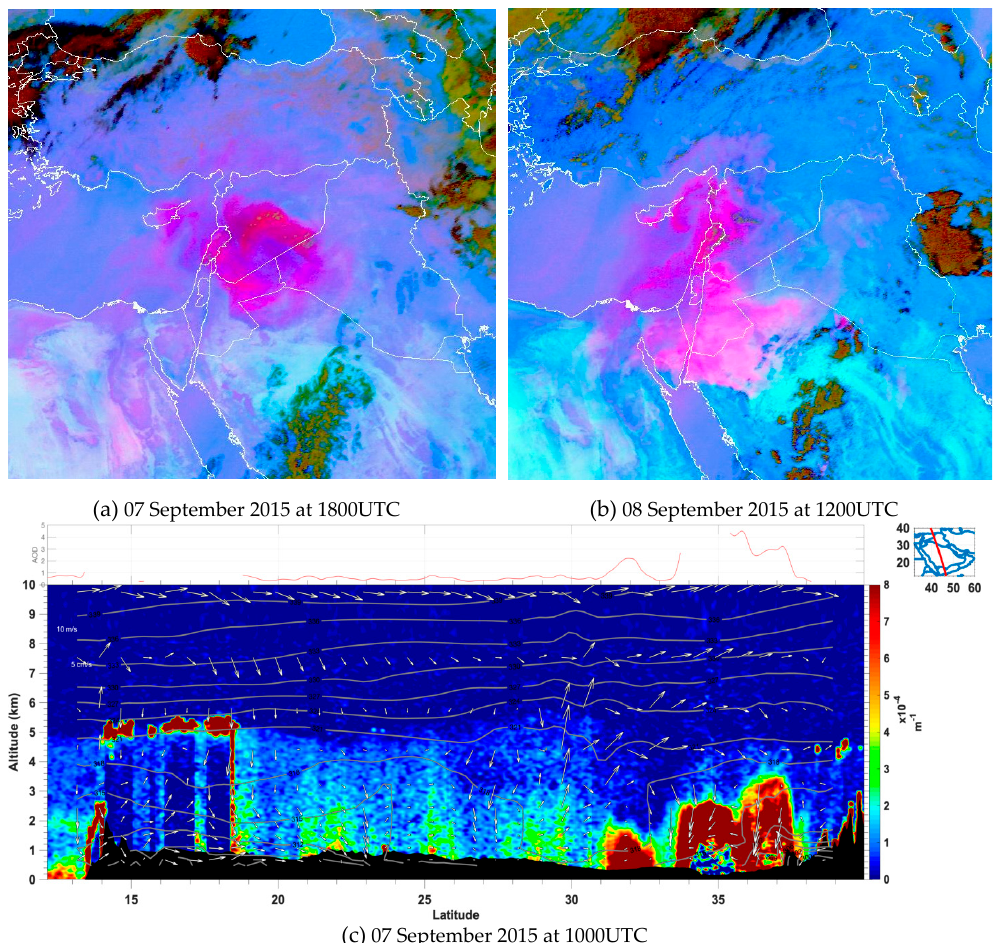
Figure 8. SEVIRI-derived false color images showing dust (pink/purple), clouds (brown/red) and differences in surface emissivity retrieved in absence of dust or clouds (light blue/blue) on 07 September 2015 at 1800 UTC ( a ) and 08 September 2015 at 1200 UTC ( b ). ( c ) CALIPSO observations on 7 September 2015 at 1000UTC of particle extinction coefficient at 532 nm on which are superimposed the wind direction and vertical velocities in vectors and the isentropes derived from ECMWF ERA5 re-analyses along CALIPSO track. The upper panel shows the AODs derived from CALIPSO at 532 nm along its path on 7 September 2015. The panel in the upper-right corner shows in red the path of CALIPSO over the study area on 7 September